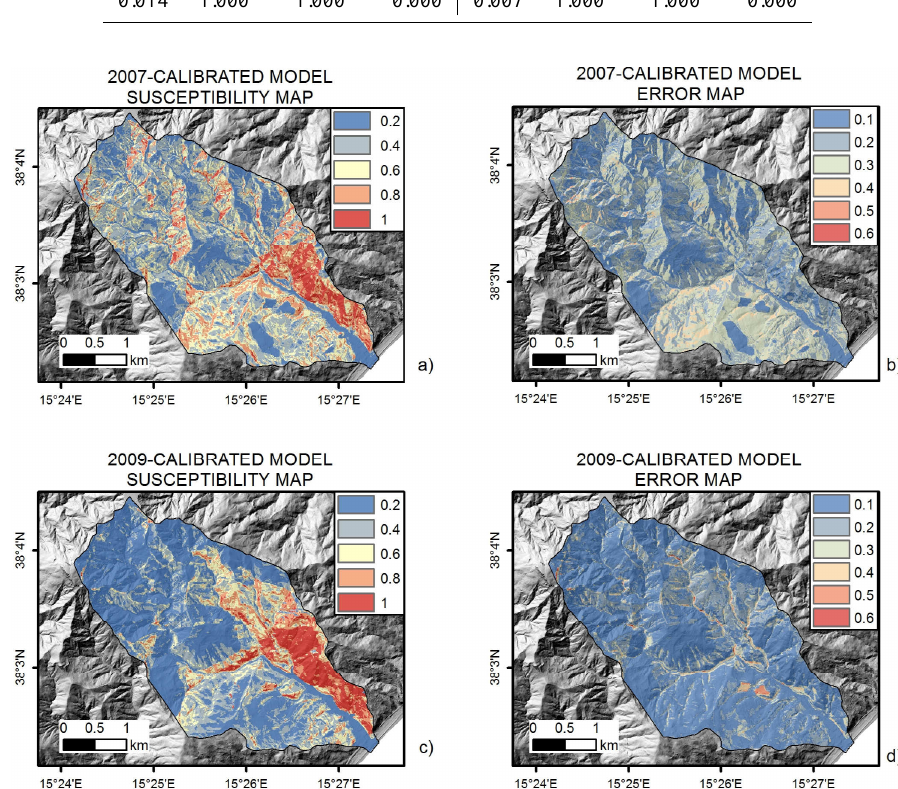
Figure 13. Susceptibility and error maps for the 2007 and the 2009 calibrated models: (a) , (c) mean susceptibility; (b) , (d) error maps.